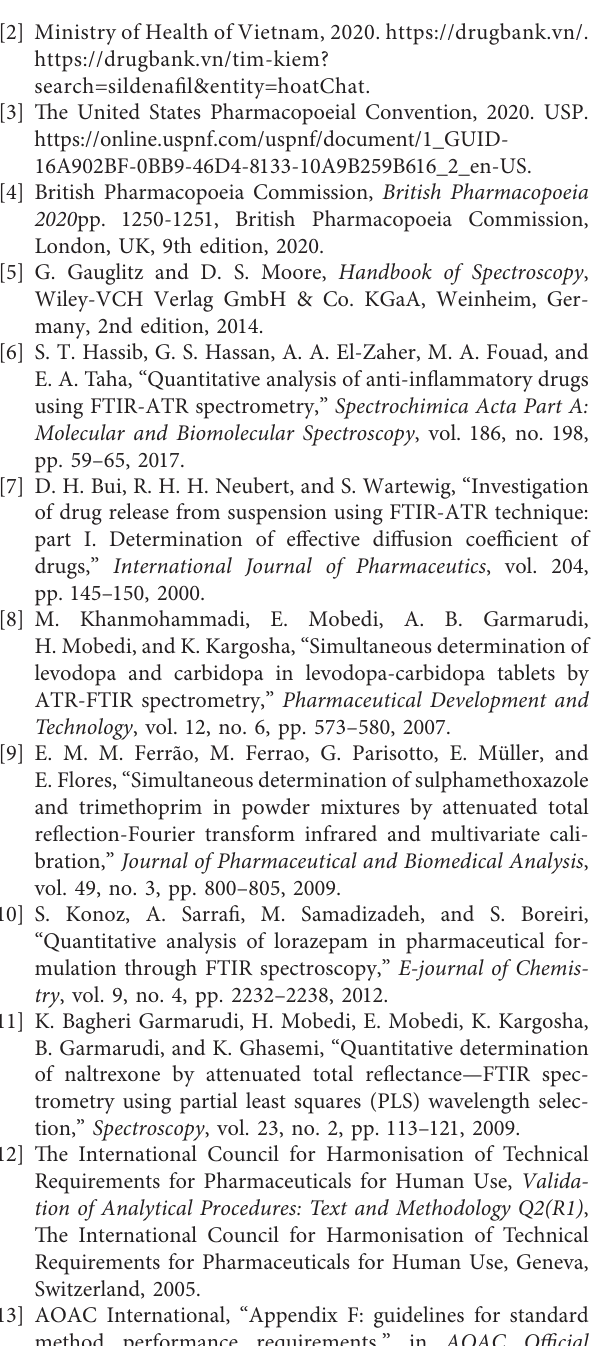
S1: results of quantitation. Figure S1. chromatogram of the standard solution (a), sample solution of batch N531 (b), and sample solution batch N532 (c). ( Supplementary Materials )